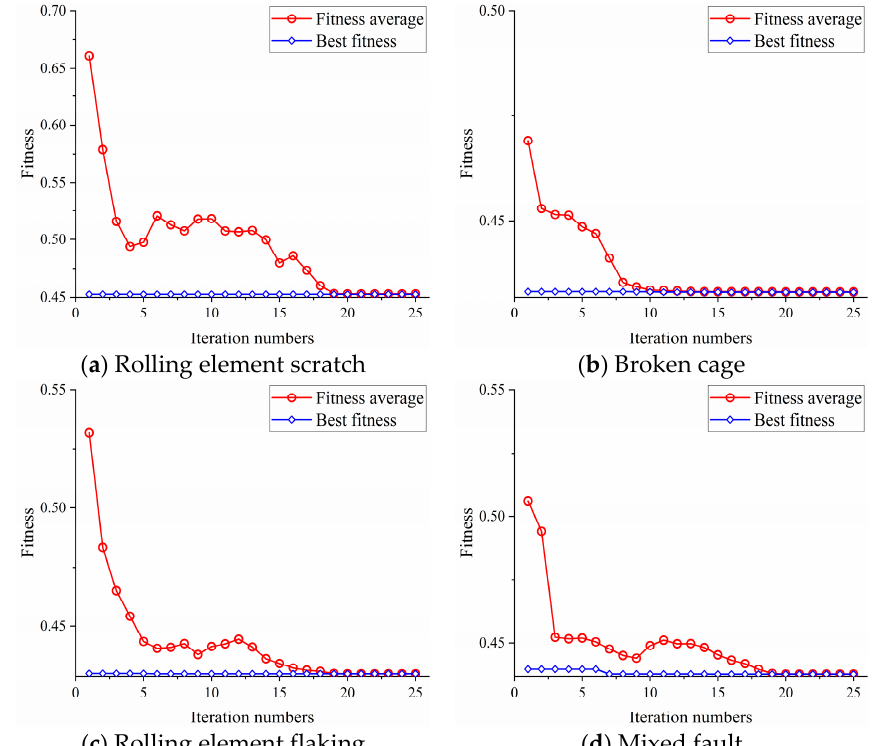
Figure 10. Optimization curve of GA. Table 2. Optimized parameters for four types of fault signals.